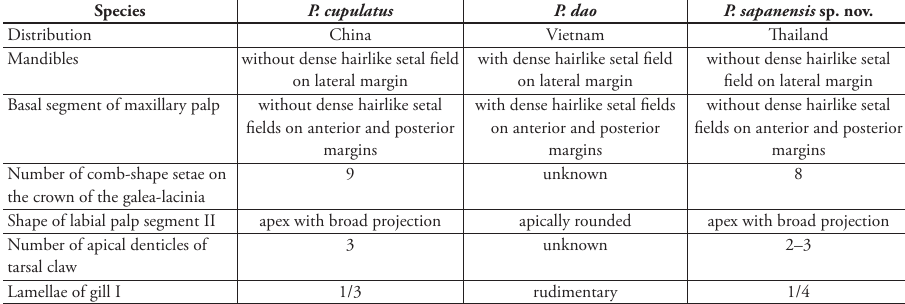
Table 2. Larval characters of Paegniodes sapanensis sp. nov. compared with known species (Nguyen and Bae 2004; Ma et al.